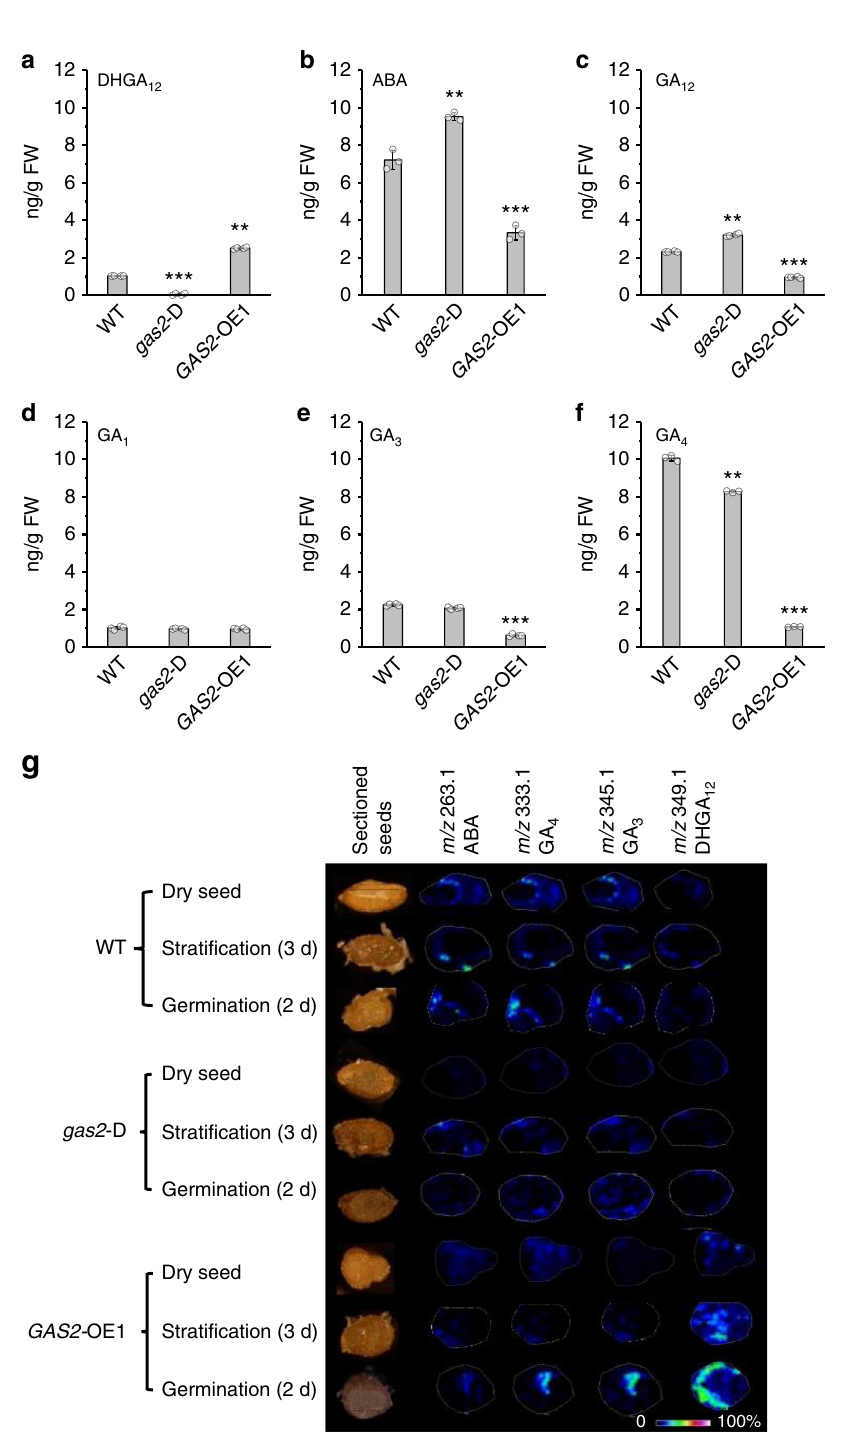
Fig. 7 Endogenous GAs and ABA levels in seeds. a – f DHGA 12 , ABA, GA 12 , GA 1 , GA 3 and GA 4 levels in wild-type, noninduced gas2 -D and GAS2 -OE1 seeds. 600 mg Arabidopsis seeds imbibed in 4 °C overnight were used for each sample. Values are expressed as means± SD (standard deviations) ( n = 3), ** P < 0.01, *** P < 0.001, t test versus WT. g Visualization of ABA, GA 3 , GA 4 and DHGA 12 in wild-type, noninduced gas2 -D and GAS2 -OE1 seeds by MALDI-TOF imaging. Representative images of >3 measurements are presented. Source data are provided as a Source Data fi le. GA gibberellins, ABA abscisic